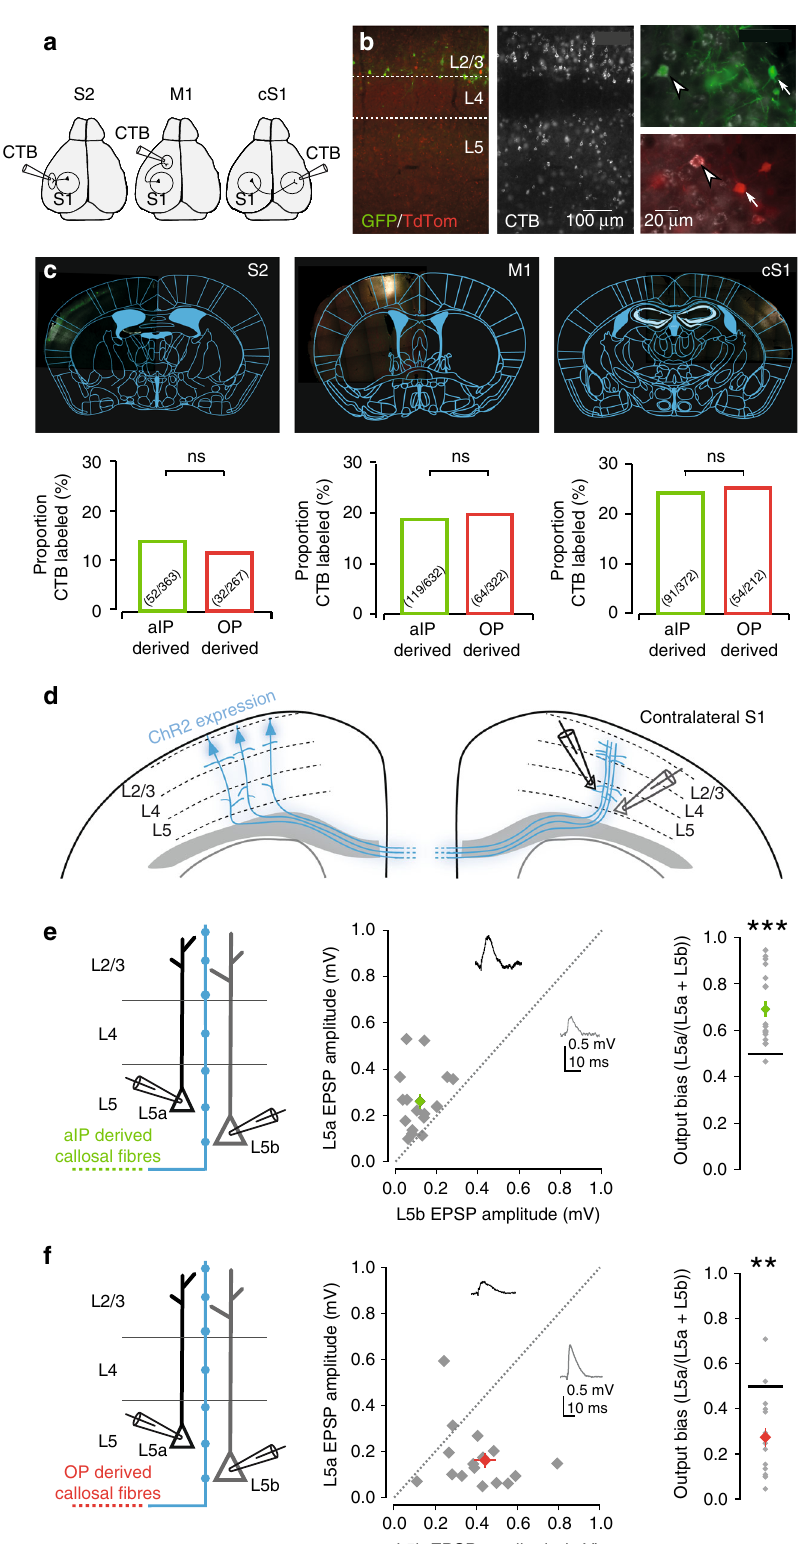
of a cortical layer. While both aIPs and OPs generate the Rspo1 glutamatergic neurons within L4, the contribution of aIPs to the population of L2/3 glutamatergic neurons was biased and more restricted when compared with that of OPs. aIPs almost exclu- sively generated Agmat L2/3 pyramidal neurons, whereas